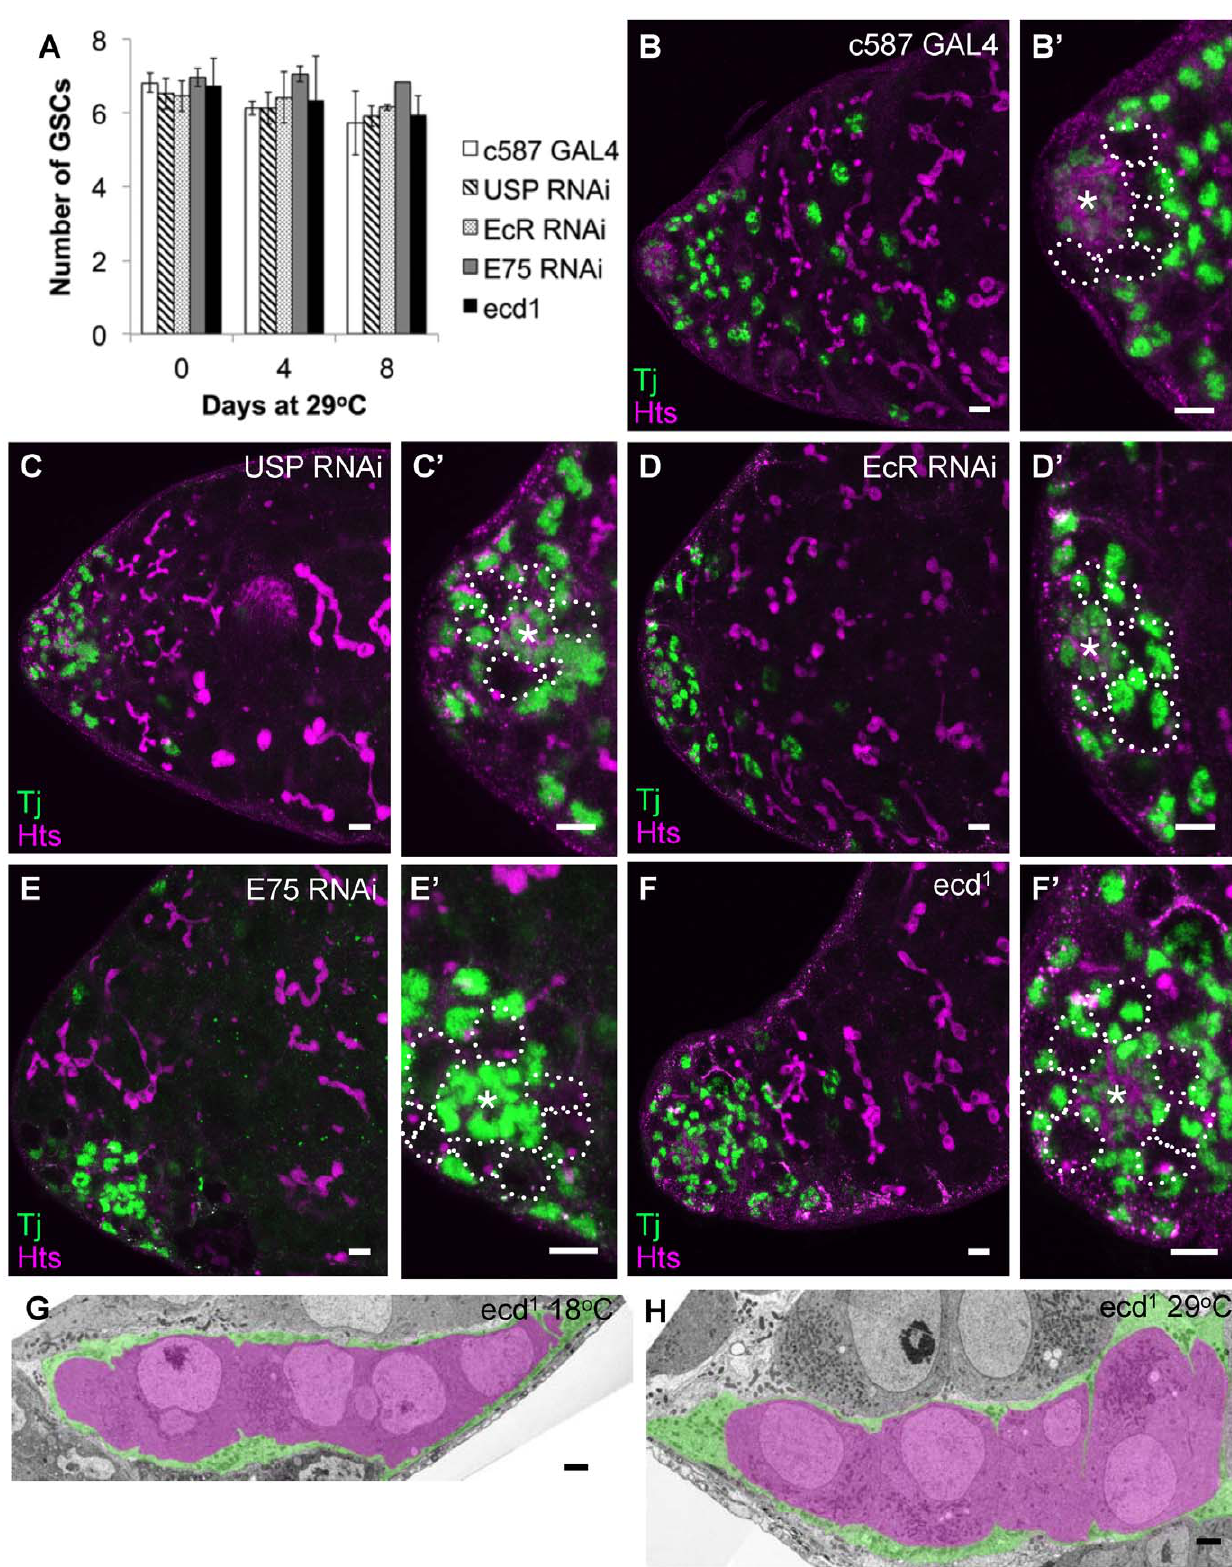
Figure 5. Ecdysone signaling is not required for GSC maintenance, early germ cell development, or somatic cell shape in the testis. A) The number of male GSCs was counted after the indicated periods following a shift to 29 u C to compromise ecdysone signaling as indicated. Error bars indicate s.d. B) c587 alone 29 u C day 8; C) c587::USP RNAi 29 u C day 8; D) c587::EcR RNAi 29 u C day 8; E) c587::E75 RNAi 29 u C day 8; F) ecd 1 29 u C day 4. (B 9 –F 9 : enlarged regions). GSCs outlined in B 9 , C 9 , D 9 , E 9 and F 9 and asterisk position of hub cells. Green: somatic cells (anti-Tj) magenta: cell